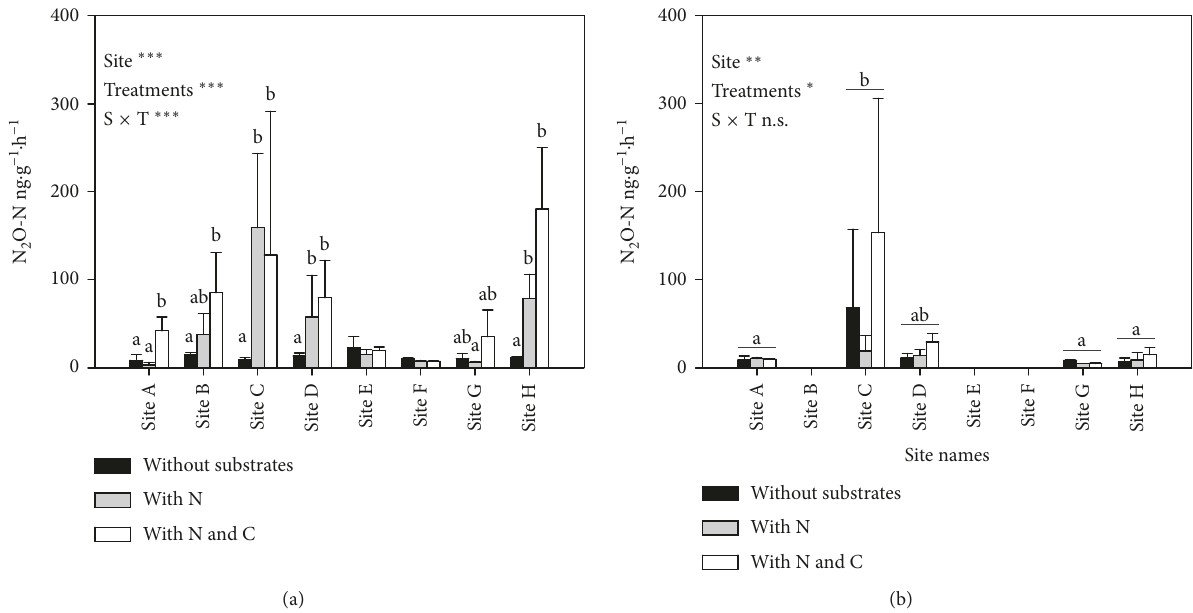
F IGURE 1: Denitrification potentials for the topsoils (0–15cm) and subsoils (15–30cm). Small letters define significant differences among three substrate treatments (“control,” “with N,” and “with C and N”), for each sampling site (A–H), for the topsoils. For the subsoils, the small letters define significant differences among the different sites. The error bars were standard deviations ( n